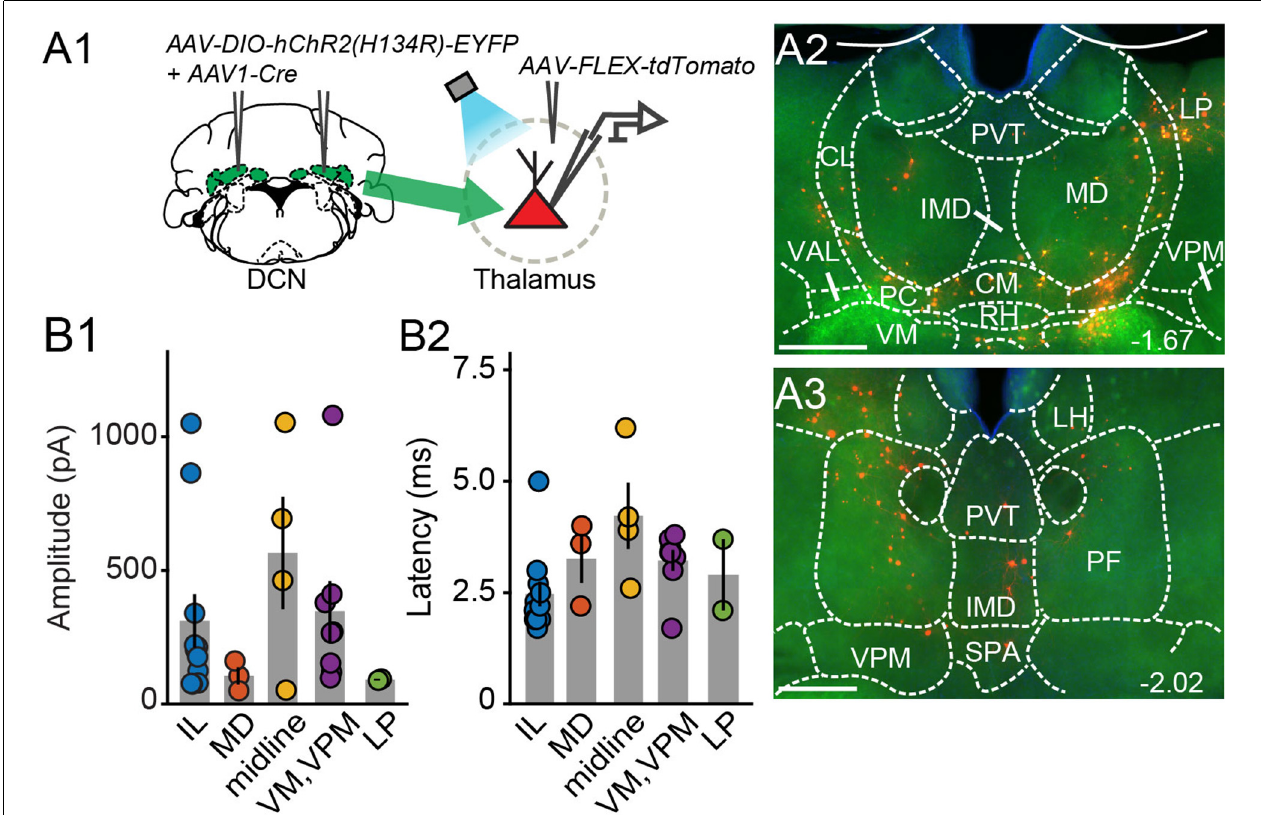
FIGURE 3 | Electrophysiological validation of virally-identified cerebello-thalamic connectivity. (A1) Schematic of experimental approach for ex vivo optophysiology. (A2,A3) Epifluorescence images of anterior (A2) and posterior (A3) thalamic slices acutely prepared for recordings. DCN input-receiving neurons are tdTomato+. Scale bars: 500 µ m. (B) Average ( ± SEM) amplitude (B1) and onset latency (B2) of ChR2-evoked synaptic currents as a function of recording location in the thalamus. Intralaminar (IL) group: CL, PC, CM, and PF; midline group: IMD and RH.